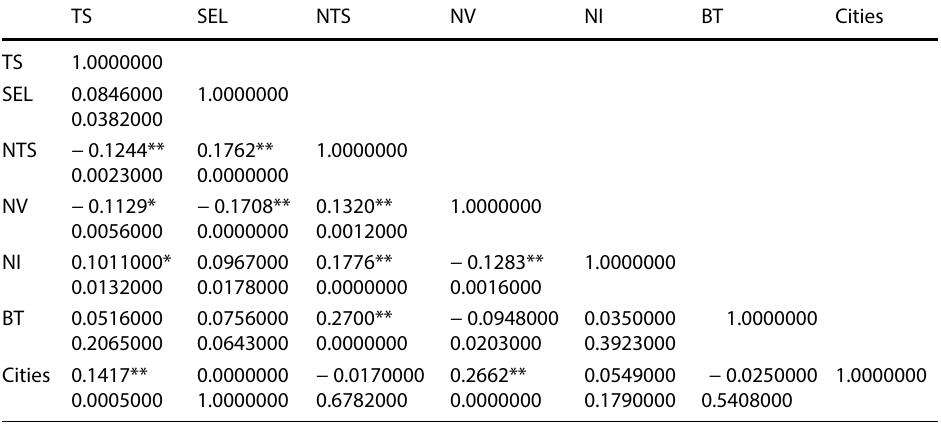
Table 5 Relationship between schools, tree biodiversity and hosted animals and city (n =